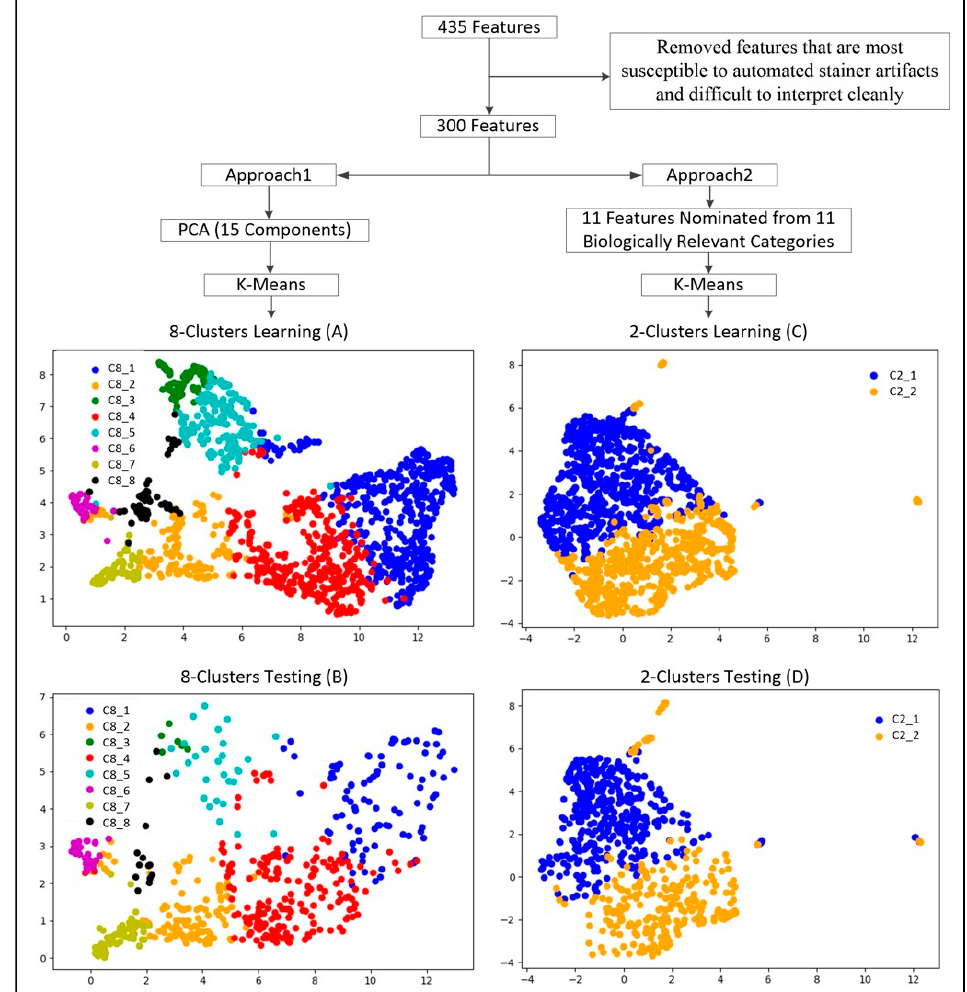
Figure 4. U-Map from K-Mean Clustering. Top : Feature selection process and number of inputs for the two K-means cluster analytic approaches (PCA vs. features nomination). Bottom : U-maps represent the clusters discovered from machine learning. U-maps A&C are from training data, B&D are from independent testing data. The training and testing U-maps shared similar patterns in cluster distribution.